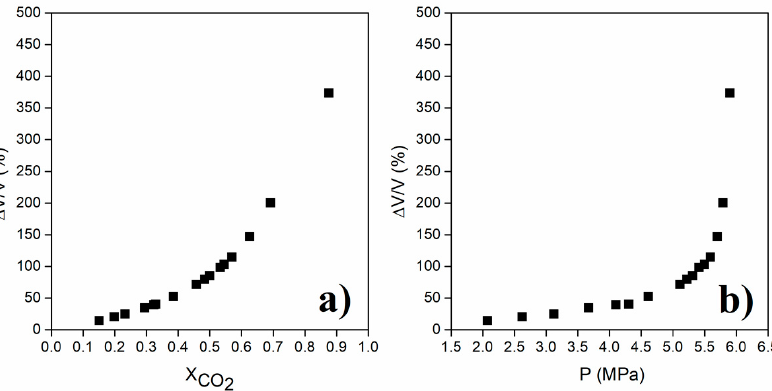
Figure 11. Relative volume expansion of ethanol vs. liquid mole fraction of carbon dioxide ( a ) and pressure ( b ) at 298.15 K. Plots are regenerated using the data available at [79]. Equation (15) shows that percent volume expansion depends on the density of the solvent-CO 2 mixture in the pores and mole fraction of CO 2 in the same mixture. At the initial stage of supercritical drying, mole fraction of the solvent inside the pores is accepted as 1 since there is only solvent in the pores. Then, CO 2 diffuses into pores whereas the solvent diffuses in the reverse direction, resulting in an increase of the mole fraction of CO 2 in the solvent. Consequently, density of the solvent-CO 2 mixture in the pores varies during drying. Figures 12 and 13 show how density varies with composition for ethanol-CO 2 and acetone-CO 2 systems for temperatures and pressures commonly employed in supercritical drying. Maximum percent density changes of the systems between the start of the drying until the point where mole fraction of CO 2 is 0.95 can be calculated from the plots as 9% and 4% for ethanol and acetone mixtures, respectively from the data given in Figures 12 and 13. Since the percent density change is small, the main parameter determining the relative volume expansion would be the mole fraction of CO 2 . Therefore, the amount of volume expansion would most likely be determined by the mole fraction of CO 2 in the pores which depends on how fast CO 2 diffuses into the pores. Since volume of the pores can be considered as constant during drying, volume expansion would eventually lead to spillage of the pore filling liquid to CO 2 stream. During volume expansion and consequent pressure increase of liquid in the pores, resistances due to surface tension and friction by pore walls are overcome so that there would be a flow and spillage of the expanded liquid. Therefore, both operating conditions and textural properties of gel would affect this transport